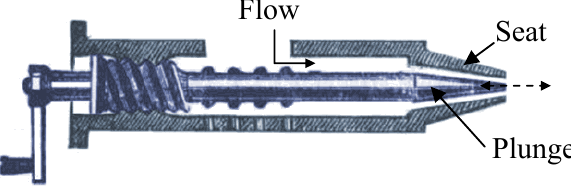
Figure 9. Macro-scale needle valve, using a tapered plunger (needle) to increase closure contact and controllability